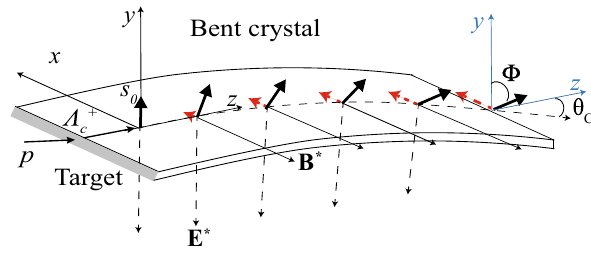
Fig. 3 Sketch of the deflection of the Λ + c baryon trajectory and spin precession in a bent crystal. The initial polarization vector s 0 is perpen- dicular to the production plane, along the y axis, due to parity conserva- tion in strong interactions. The spin precession in the yz and xy plane are induced by the MDM and the EDM, respectively. The red (dashed) arrows indicate the (magnified) s x spin-polarization component propor- tional to the particle EDM. The Φ angle indicates the spin precession due to the MDM